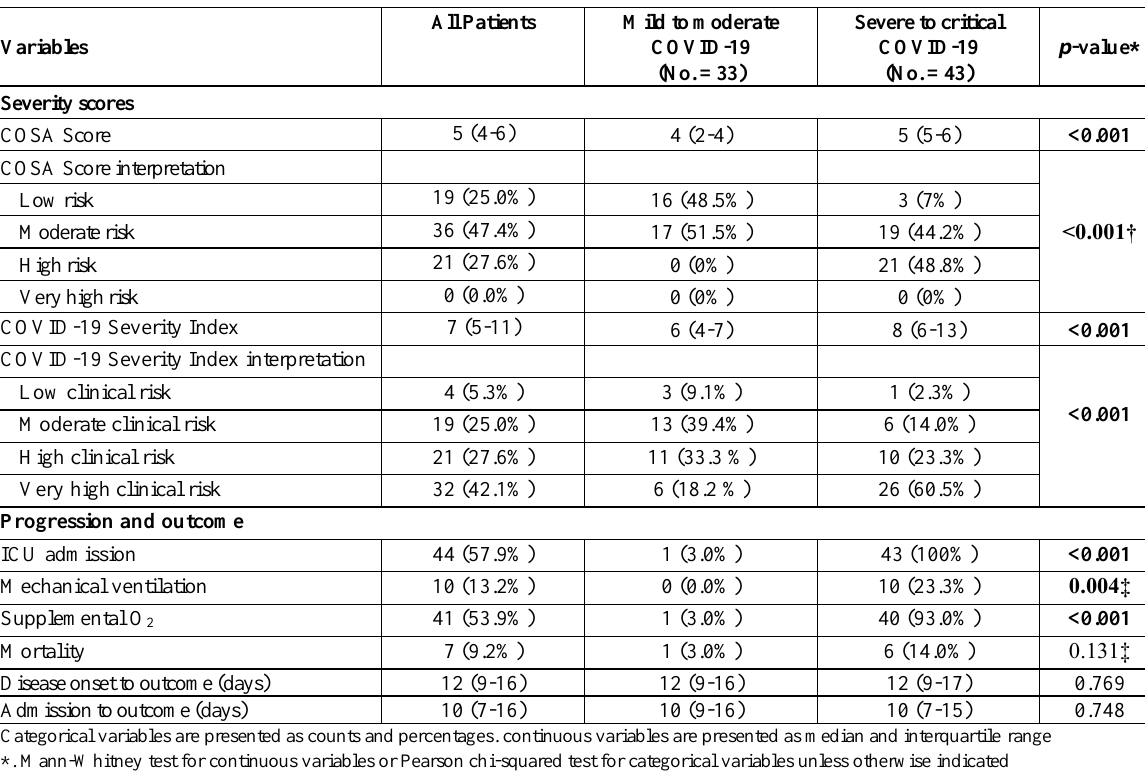
Table 2. COVID-19 severity, progression, and outcome of the whole study